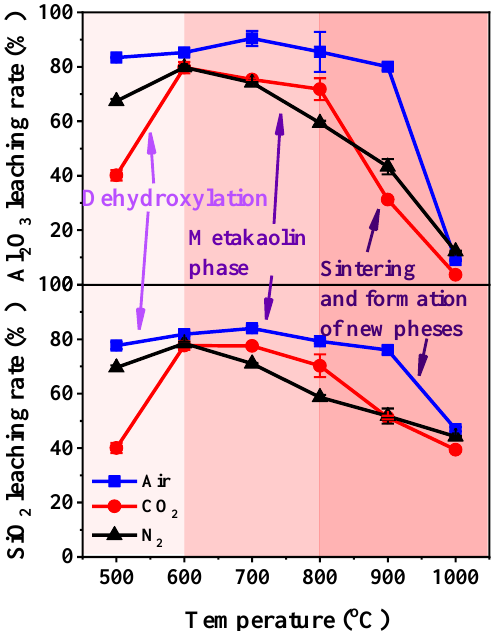
Figure 12. The leaching rate of Al 2 O 3 and SiO 2 in calcined KAS.